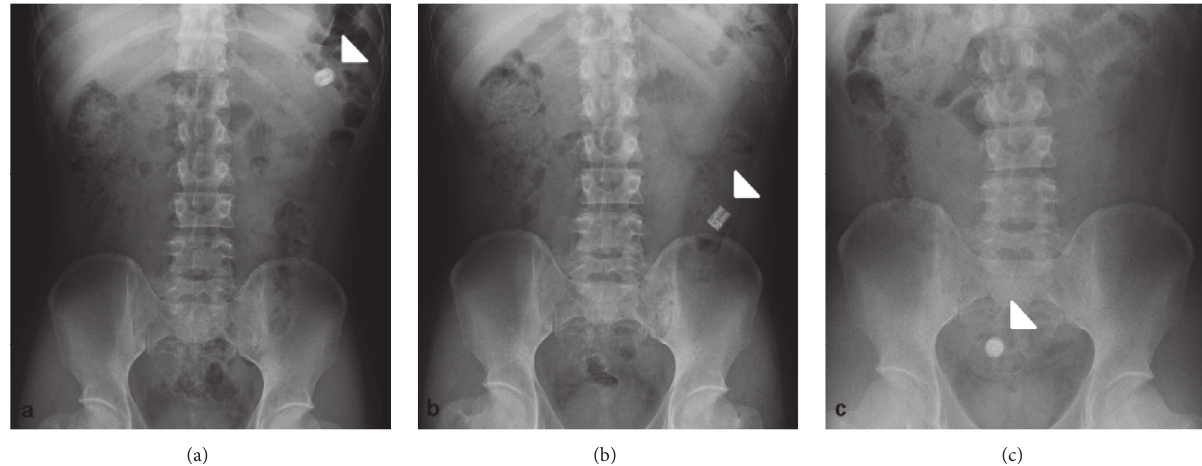
Figure 1: Abdominal radiographs taken at (a) 31, (b) 56, and (c) 218 hours after ingestion showing the patency capsule to be moving anally, but finally becoming retained in the right iliac fossa (arrowheads).